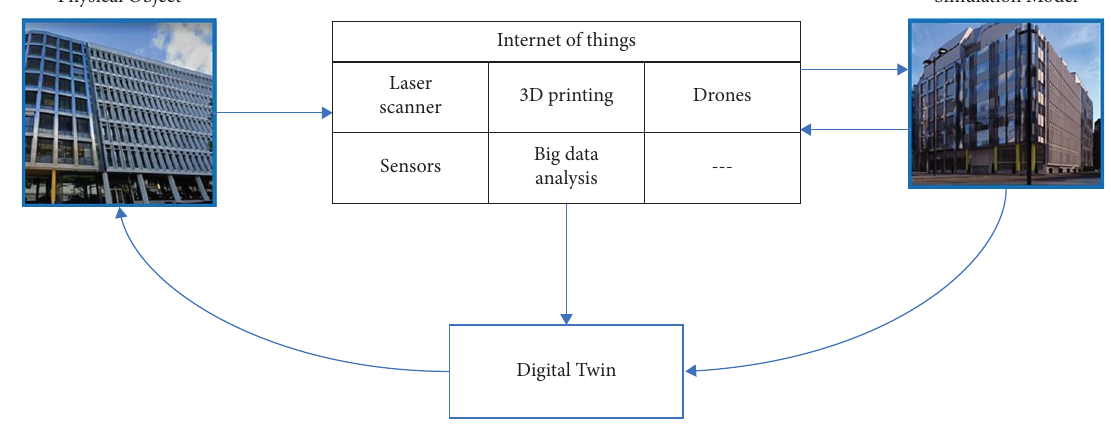
Figure 1: Digital Twin